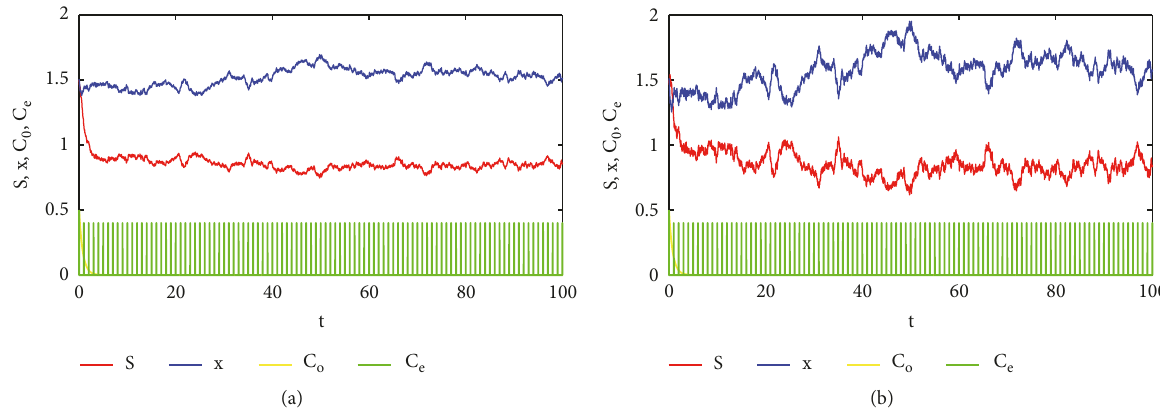
Figure 2: Numerical simulations of persistence in mean of system